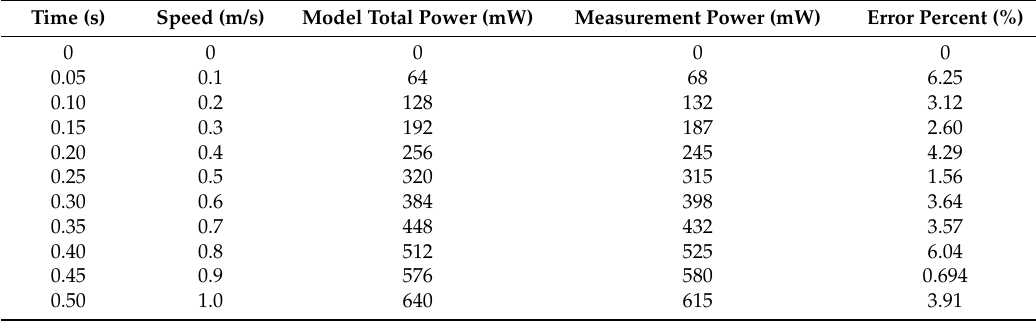
Table 2. Sensor power comparison between model and measurement.